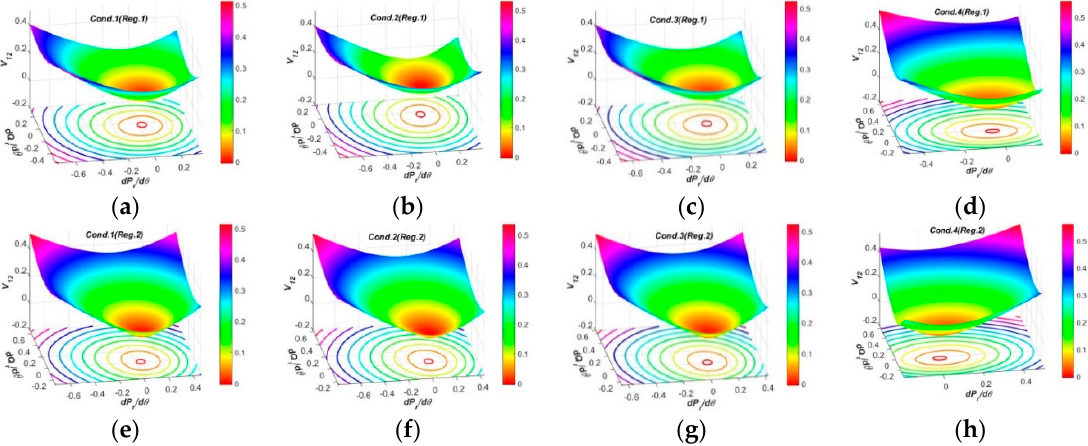
Figure 12. Spatial surfaces of PFG to CIV2 at SCP4 in spaces: ( a – d ) Spatial surfaces of PFG to CIV2 by Reg.1 mode of OSIV in four operation conditions; ( e – h ) Spatial surfaces of PFG to CIV2 by Reg.2 mode of OSIV in four operation conditions.